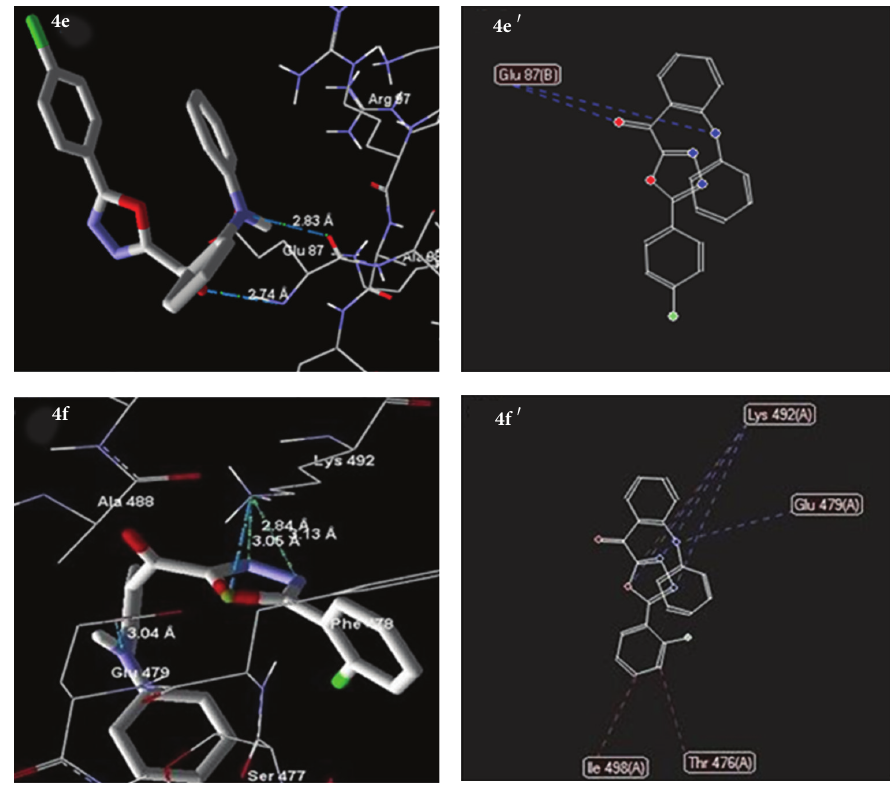
Figure 4: Binding modes of 4e , 4f ( 4e , 4f as docking view and 4e 󸀠 , 4f 󸀠 as interaction view) with COX-2, where blue/green lines and red lines represent hydrogen bonding and favourable steric interactions, respectively. Table 2: Analgesic activity of synthesized 1,3,4-oxadiazole analogues. Reaction time